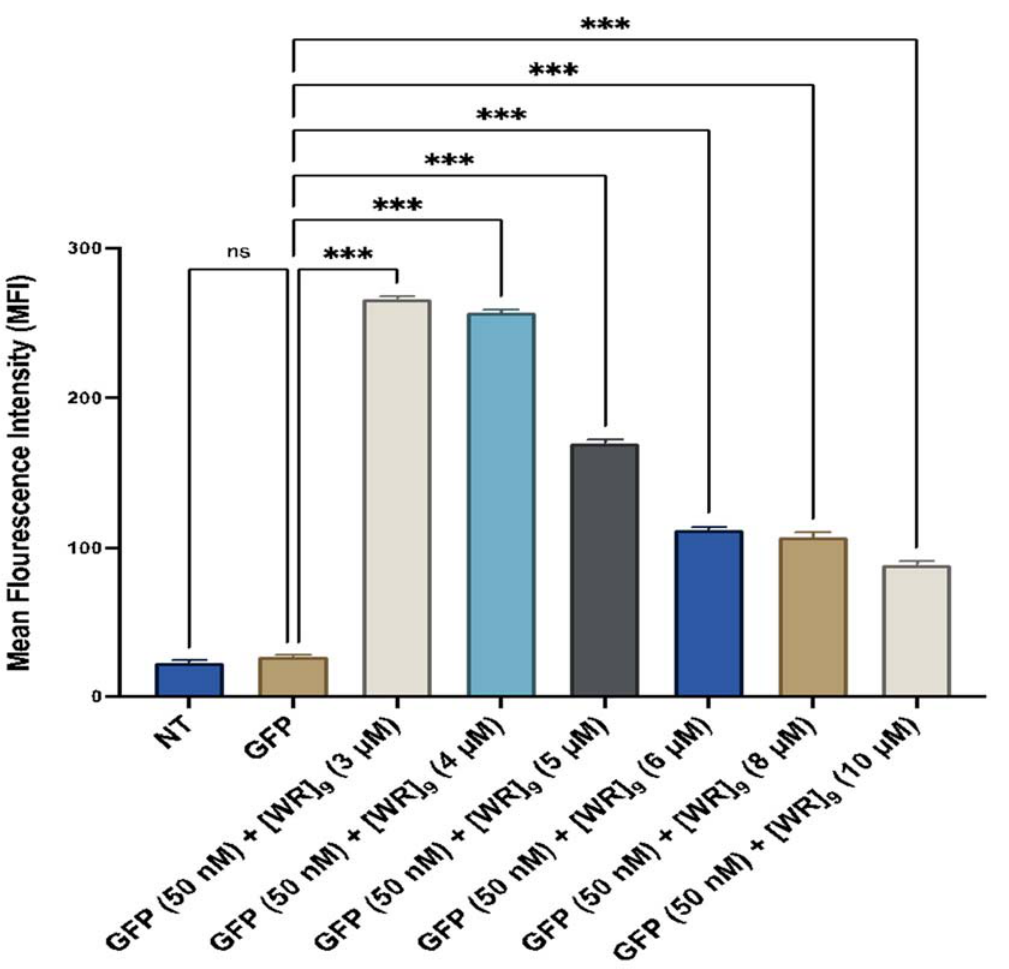
Figure 16. Cellular uptake of GFP-[WR] 9 mixture at a peptide concentration (3–10 μ M) and GFP at (50 nM) for 3 h in MDA-MB-231 studied by flow cytometry. The results are mean ± SD ( n = 3) (ns; no significance, *** p < 0.001), treatment vs. Ctrl (GFP